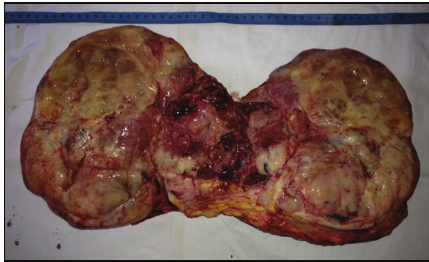
Figure 7: Cut surface of the specimen.